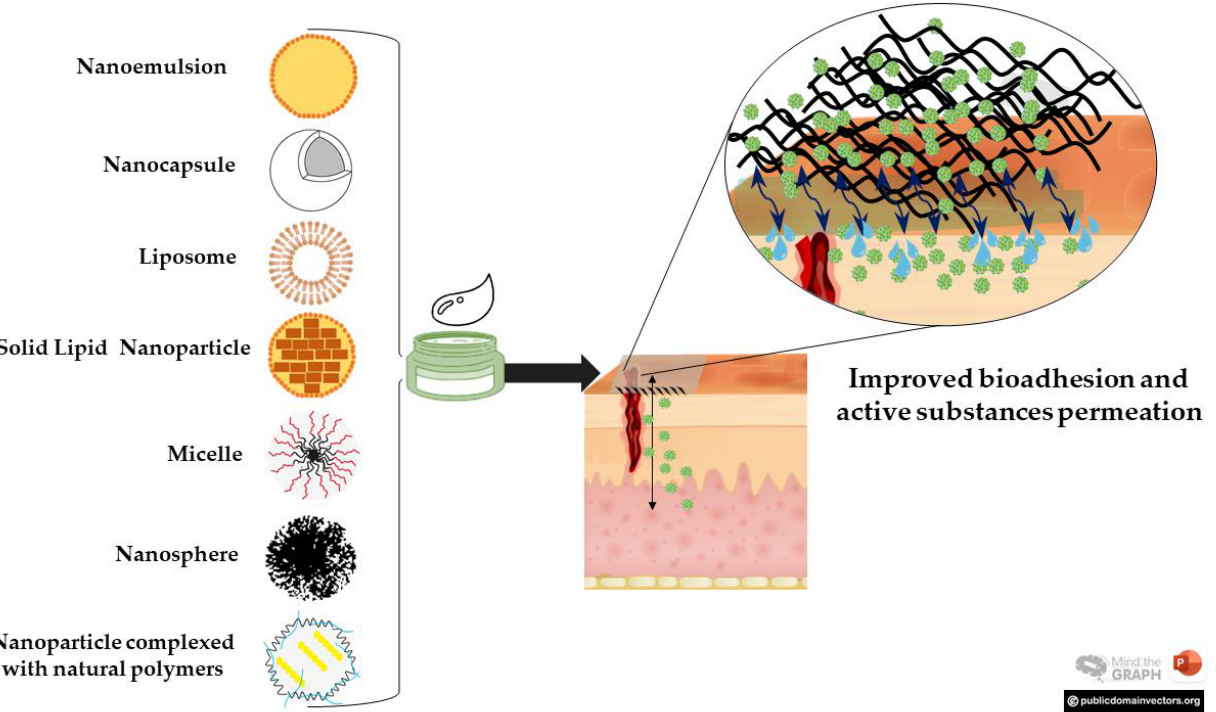
Figure 2. Nano-based hydrogels containing soft-particle-loaded active substances may improve the healing process. The major functions of wound dressings are to remove wound exudates, prevent the entry of harmful bacteria from the wound, and promote the establishment of the best milieu for natural healing. The association of nanocarriers can enhance the bioadhesiveness of the hydrogel and the permeation and penetration of actives at the wounded site, accelerating the healing process. The image was created using Mind the Graph platform (www.mindthegraph.com, accessed on 8 January 2022 ), Publicdomainvectors.org site (https://publicdomainvectors.org/, accessed on 8 January 2022), and Microsoft ® PowerPoint ® (Washington, DC, USA).